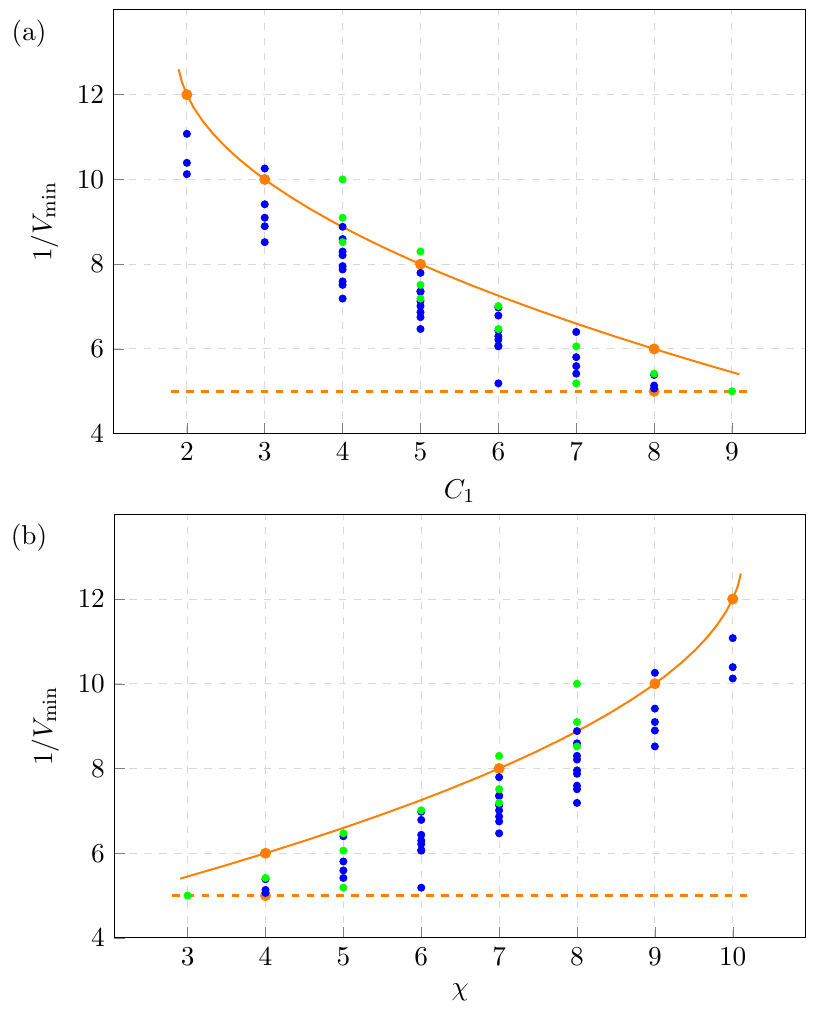
^ X ((cid:1)) built from (cid:12)rst-grade points. The varieties (from